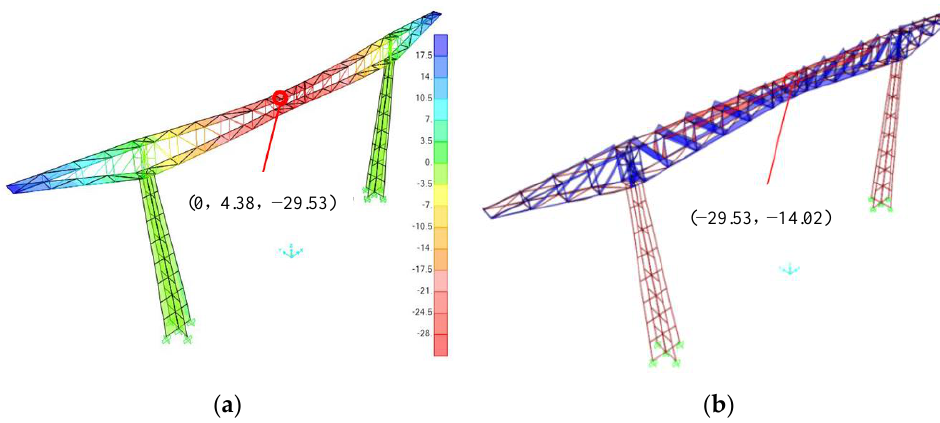
Figure 9. Condition 6. ( a ) Deformation pattern. (b) Stress diagram.